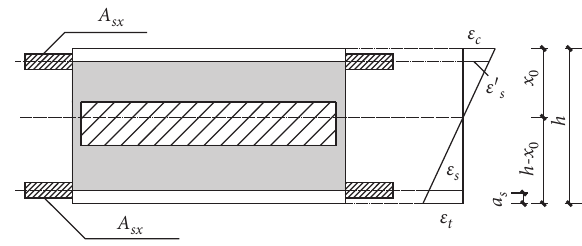
Figure 15: Equivalent converted section strain diagram.